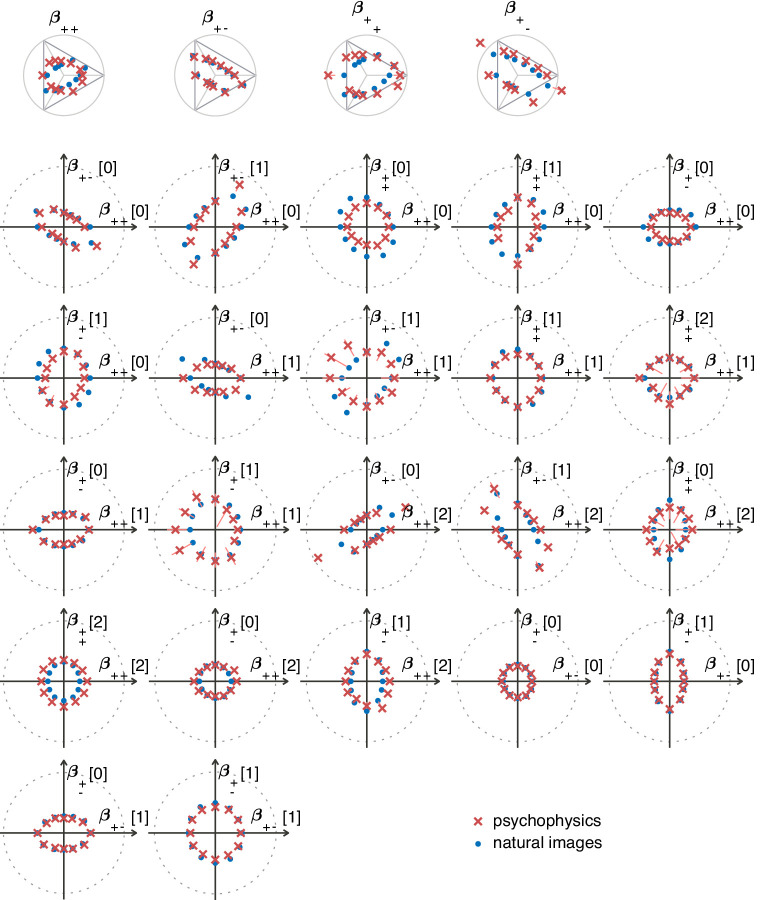
Natural image predictions (blue dots) for second-order planes when using the van Hateren image database (van Hateren and van der Schaaf, 1998).The psychophysics measurements are also shown, in red crosses. The notations are as described in the main text (Figure 5).